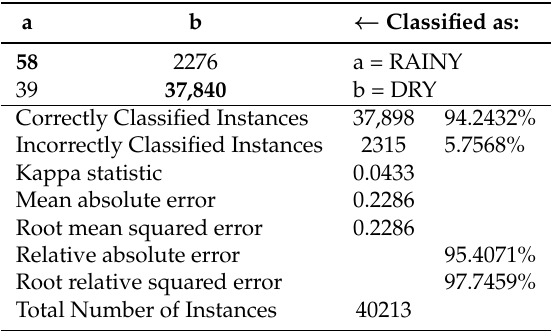
Table 4. Error Matrix for Period Classification in the testing dataset.